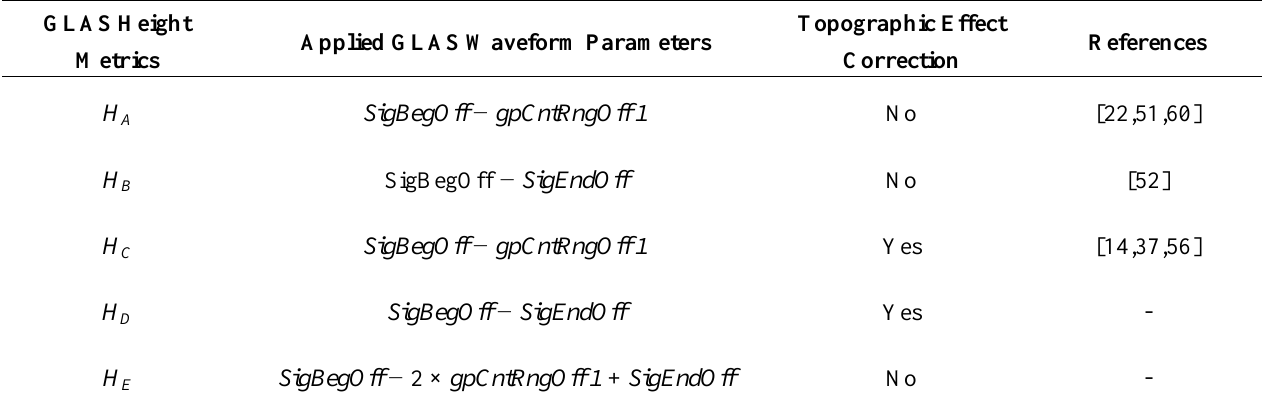
Table 4. Five possible GLAS height metrics based on Gaussian decomposition approach and topographic effect correction. Statistical analysis examining the full GLAS waveform extents [24,55,58,59] is beyond the scope of this